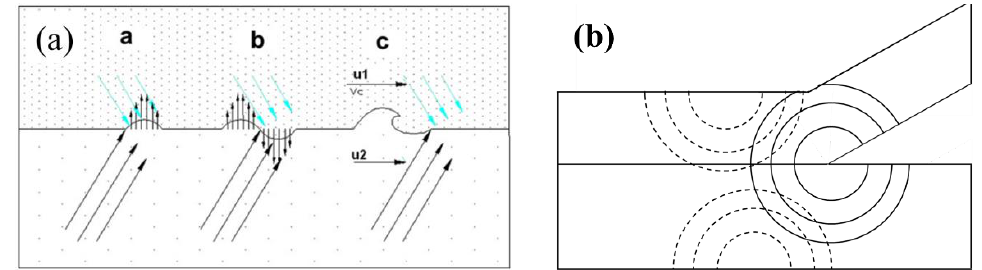
Figure 10. ( a ) Helmholz instability mechanism (reproduced from [37], with permission of Elsevier 2010); ( b ) stress wave mechanism.